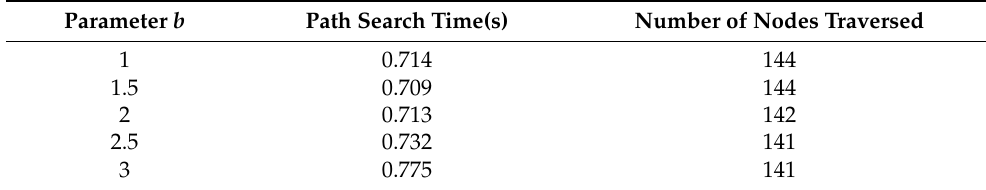
Table 1. Path search time and number of traversed nodes corresponding to different b values. Parameter b Path Search Time(s) Number of Nodes Traversed